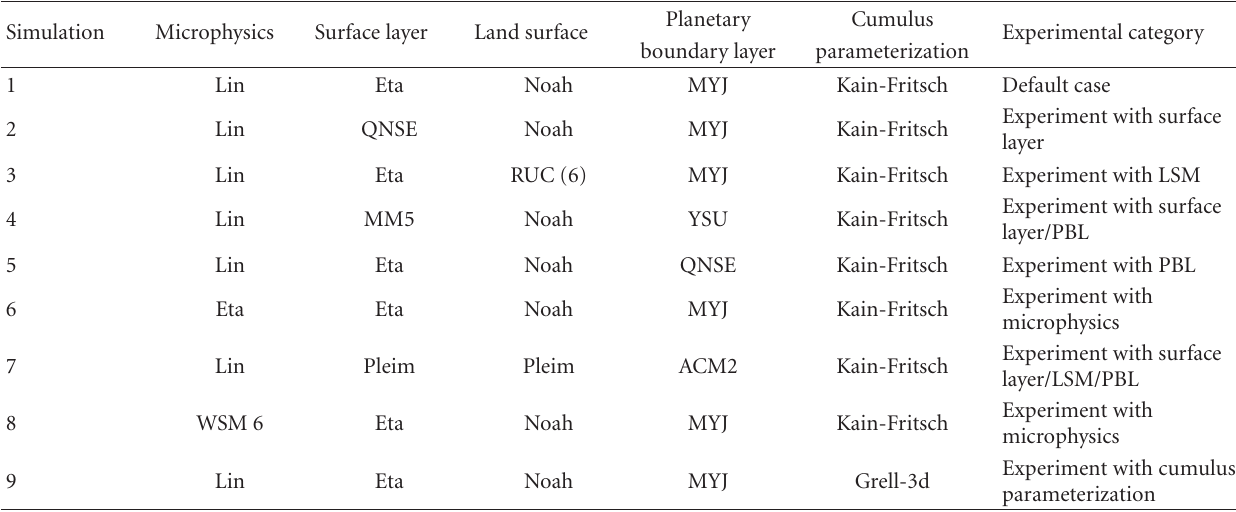
Table 1: Simulations options used in the study.